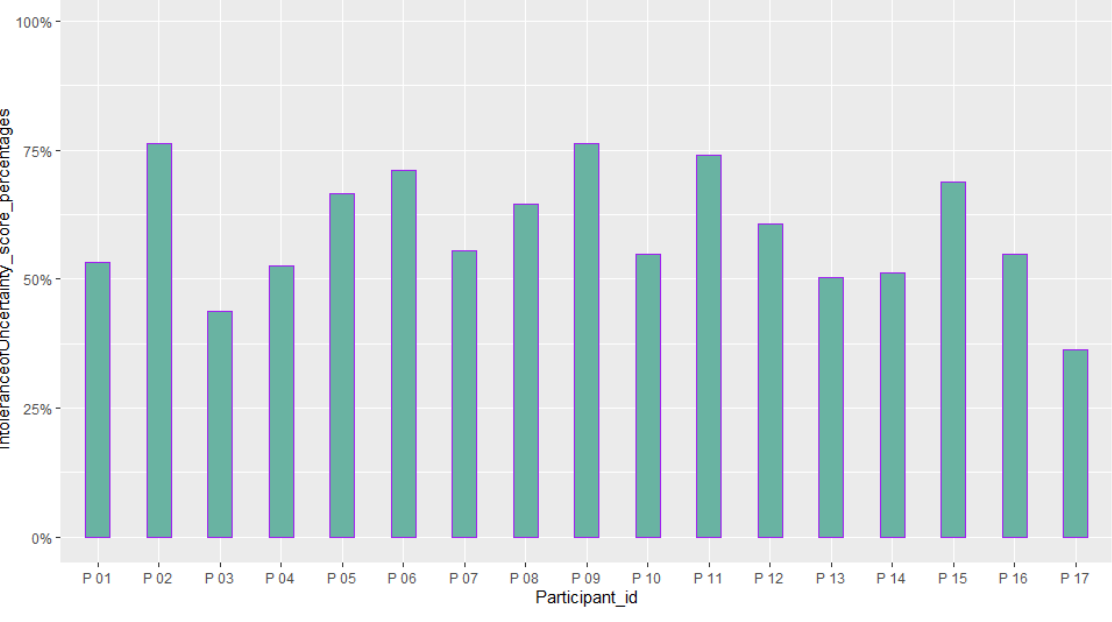
Figure 20. A comparison between the scores obtained from the participants from the Intolerance of Uncertainty Scale (IUS) (M = 59.48 (%), SD=11.63